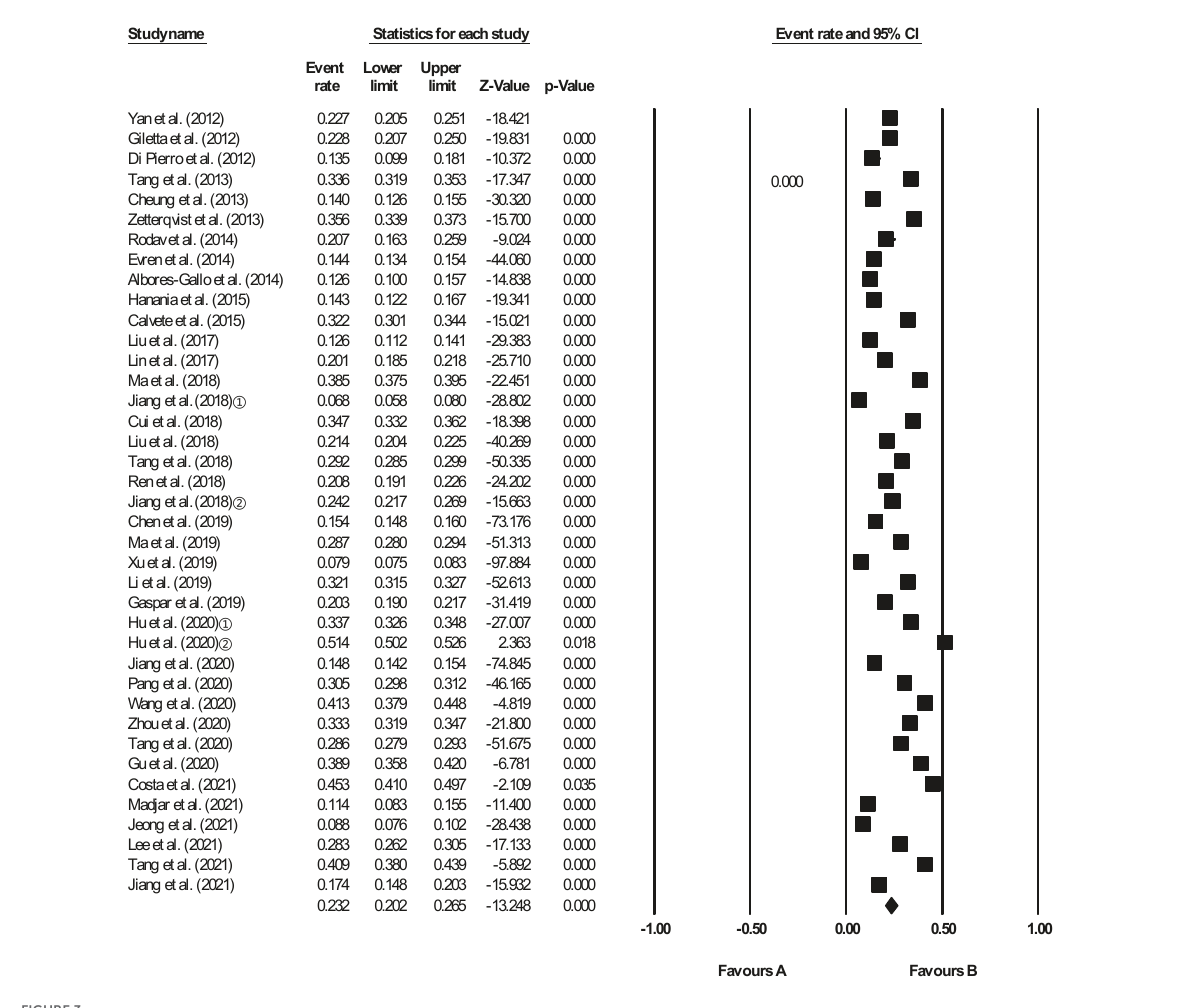
FIGURE3 Forest plot of the 12-month aggregate prevalence of non-suicidal self-injury (NSSI) in